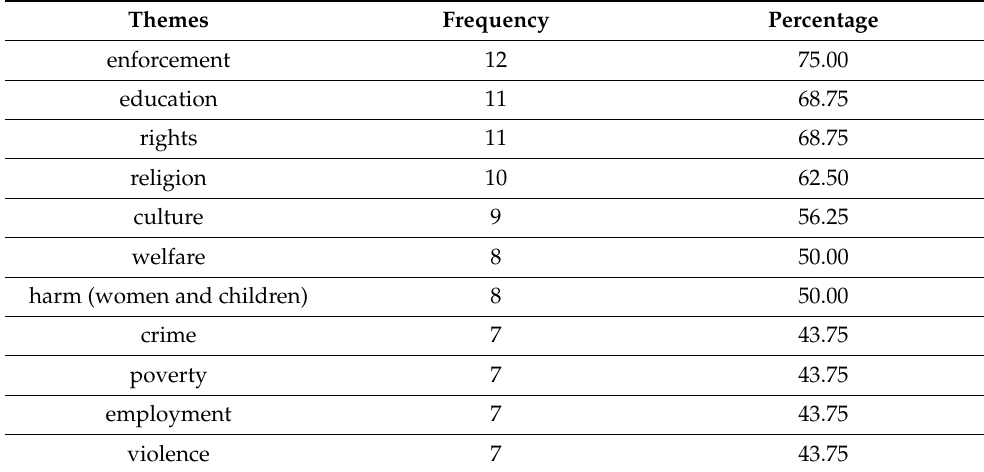
Table 4. Jerusalem